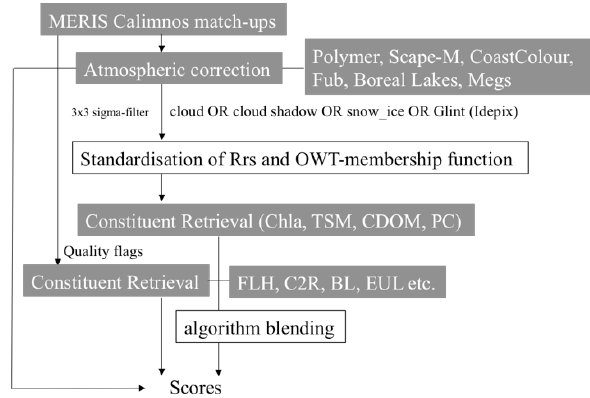
Figure 3. Flowchart of algorithm blending development and assessment.